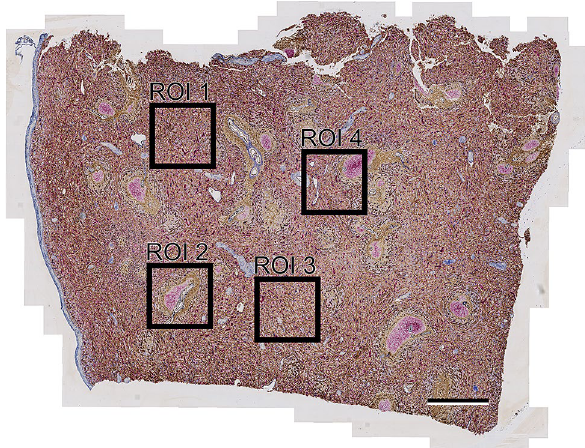
Figure 2. Overview of section No. 1 showing the location of ROIs 1–4. The left contour of the section is formed by the splenic capsule. Scale bar = 1